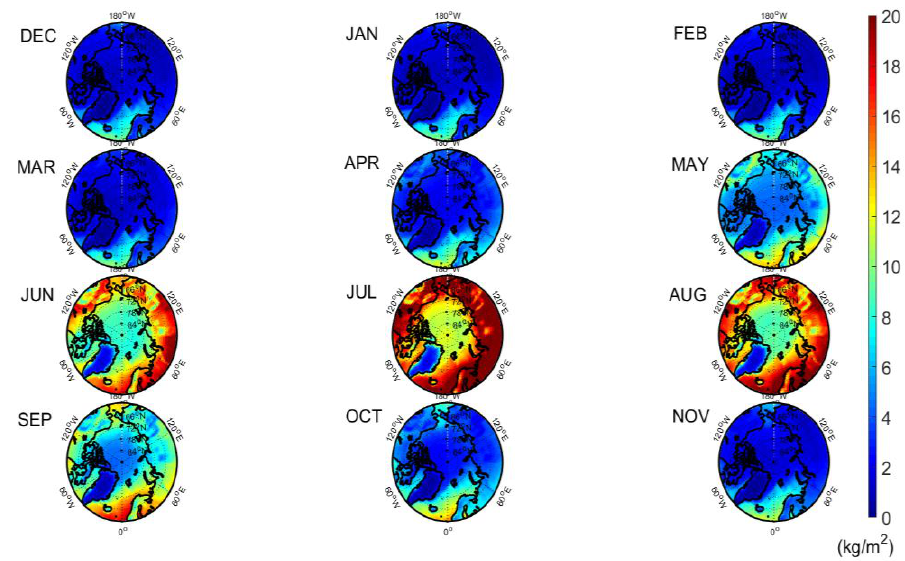
Figure 1. Monthly distribution of 2001–2015 total column-integrated density of water vapour (TCWV) mean in kg m −2 .